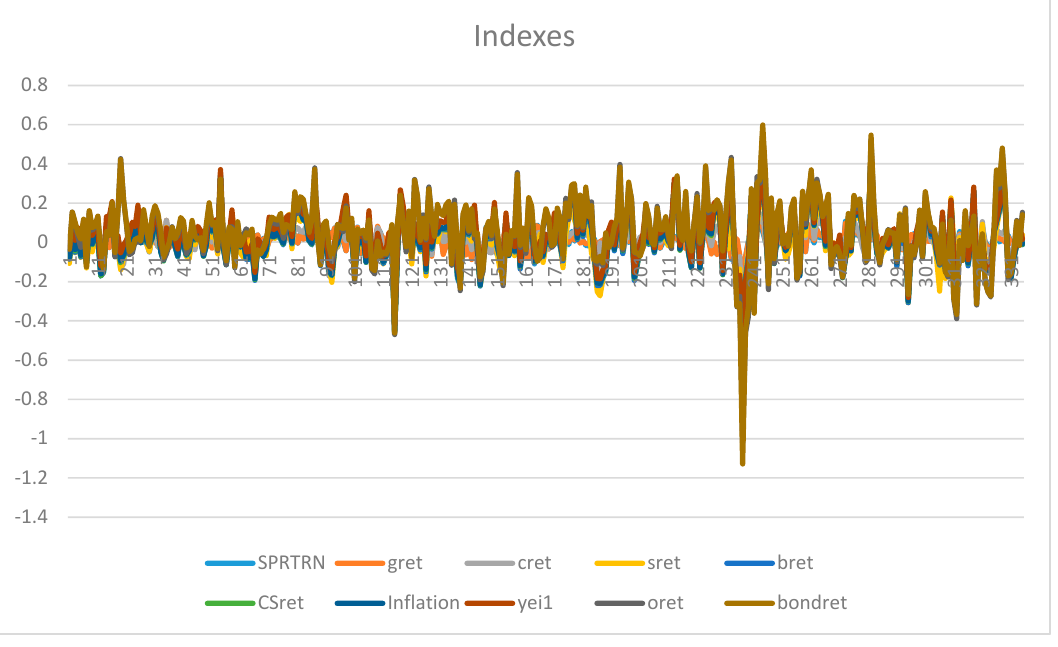
Figure 1. Index returns graph.